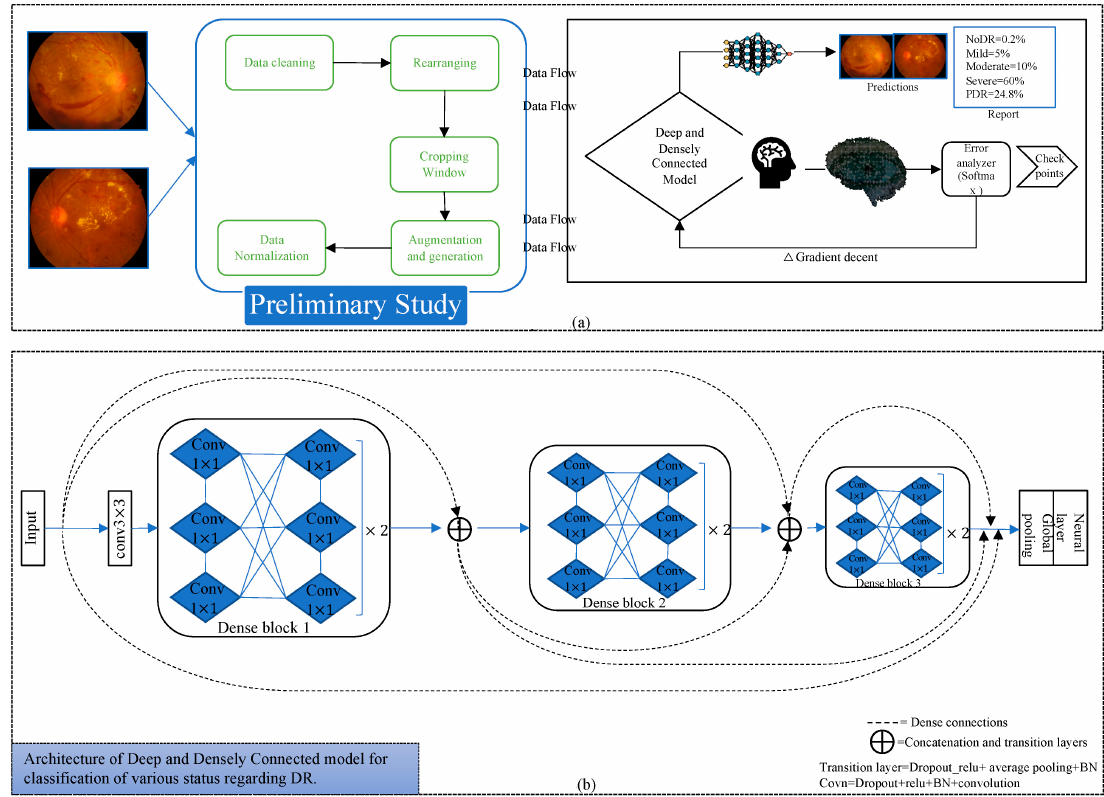
Figure 2. Process diagram for the execution of our method and details of the deep learning model. ( a ) Preliminary study including the initial manual data cleaning, rearranging dataset, designing the cropping window for various sizes of images to discard circular informative part, data augmentation for unbalanced classes to reduce overfitting, and data normalization. Moreover, the second part describes the general process of training and inference for datasets. ( b ) Architecture of deep and densely connected models for our implementation of a deep learning model to diagnose the status of diabetic retinopathy (DR). The model deploys three dense blocks with twelve convolutional layers in each and two transition layers with average pooling. It is a relatively deeper network to train; therefore, the dropout applies on each convolution layer to mitigate over-fitting with the model. The neural layer is a conventional dense (flatten) layer to convert feature maps to vectors that further contribute to the loss function. (The dotted lines mean concatenated connections between the layers of CNN, and the solid lines represents simple connection between the